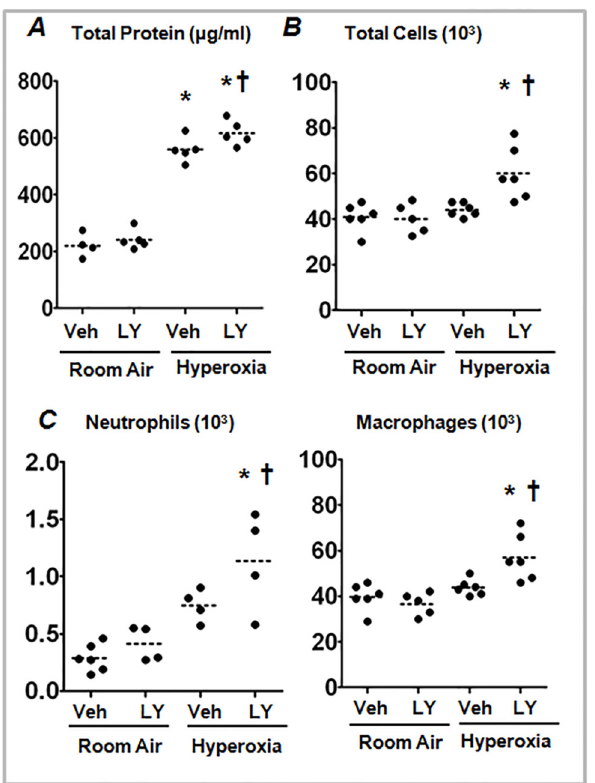
Fig 1. PI3K/AKT inhibition exacerbates hyperoxic lung injury in Nrf2 +/+ mice. Mice were treated i . p . with LY294002 (LY) or DMSO (vehicle) 1 h prior to exposure and at 24 h intervals during hyperoxia exposure. Mice were exposed to 95% oxygen for 48 h at which time lungs were harvested. The BAL fluid was collected to measure both total cell counts and protein concentration, as markers of lung inflammation and lung injury (permeability), respectively. (A) Total protein in the BAL fluid of room air or hyperoxia-exposed mice treated with vehicle or LY. (B) Total cells in the BAL fluid of room air- or hyperoxia-exposed mice treated with vehicle or LY. (C) Total neutrophils and macrophages in the BAL fluid of vehicle- or LY-treated mice were exposed to room air or hyperoxia. BAL fluids (100 μ l) were cytospun onto microslides and stained with Diff Quick stain kit. Differential cell counts were enumerated by counting a total number of 300 cells. The horizontal and vertical lines were plotted as median ± interquartile range for each group (n = 4 – 5). One-way ANOVA with Bonferroni corrections was performed for multiple group comparisons. * P < 0.05, hyperoxia vs room air; † P < 0.05, vehicle vs